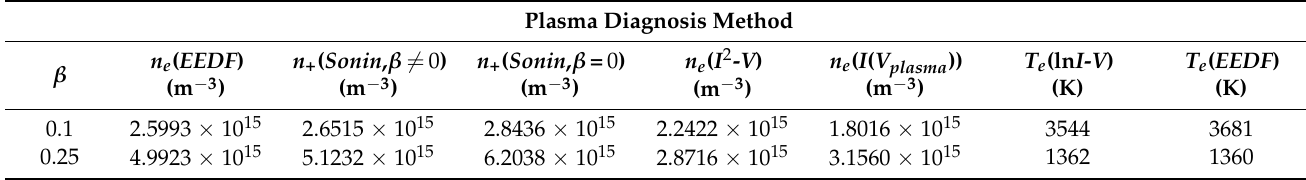
Table 2. Comparison of the results obtained using the different plasma diagnosis methods as a function of β . Plasma Diagnosis